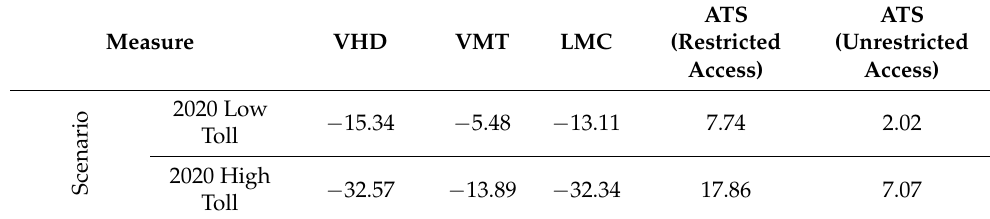
Table 1. Percentage change in Manhattan network measures in pricing scenarios.